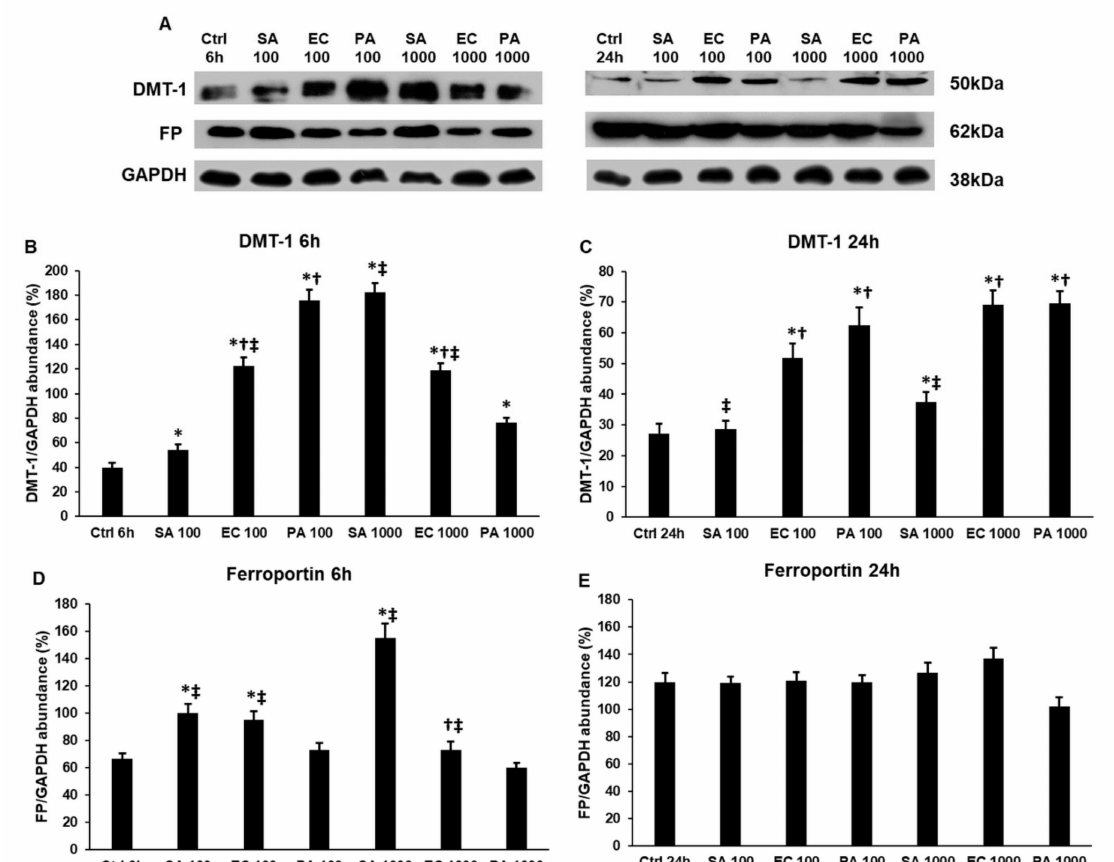
Figure 4. Western blot analyses of iron transporters divalent metal transporter-1 (DMT-1) and ferroportin (FP)in lipoteichoic acid (LTA)- and lipopolysaccharide (LPS)-treated THP-1 cells. THP-1 cells were collected and pelleted after LTA and LPS treatments. The same amount of protein from each lysate was separated by SDS-PAGE using 12% polyacrylamide gel, transferred by electroblotting to nitrocellulose membranes. The membranes were probed with anti-DMT-1 and anti-FP polyclonal rabbit antibodies according to the manufacturer’s protocols. GAPDH was used as loading control. ( A ) Western blot analysis of DMT-1 and FP proteins in THP-1 cells treated with S. aureus LTA, E. coli LPS and P. aeruginosa LPS. ( B – C ) Optical density analyses of DMT-1 in THP-1 cells. ( D , E ) Optical density analyses of FP in THP-1 cells. The columns represent mean values and error bars represent standard deviation (SD) of three independent determinations ( n = 3). An asterisk * marks p < 0.05 compared to the controls. A cross † indicates p < 0.05 compared to S. aureus LTA treatment and a double cross ‡ shows p < 0.05 compared to P. aeruginosa LPS treatment. Abbreviations: SA: S. aureus LTA; PA: P. aeruginosa LPS; EC: E. coli